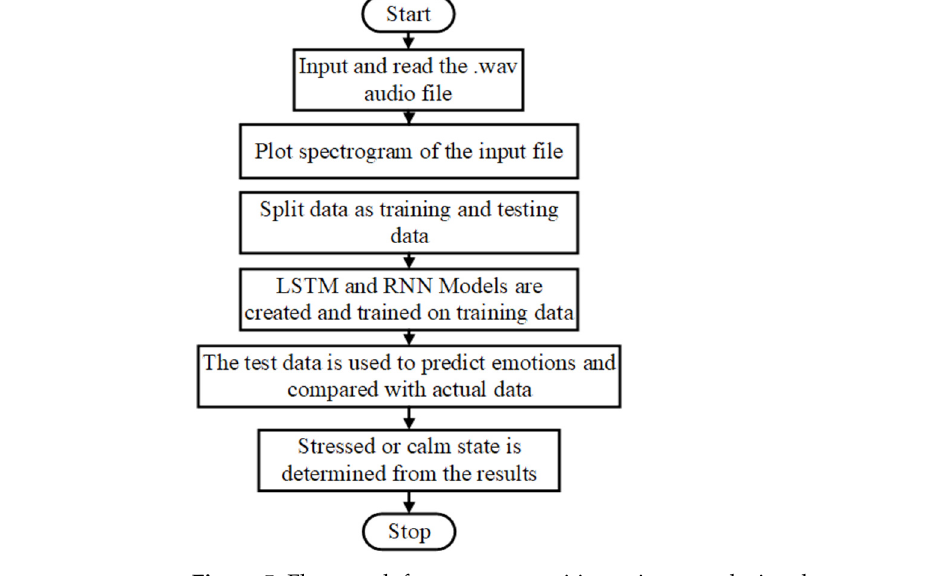
Figure 5. Flowgraph for stress recognition using speech signals.